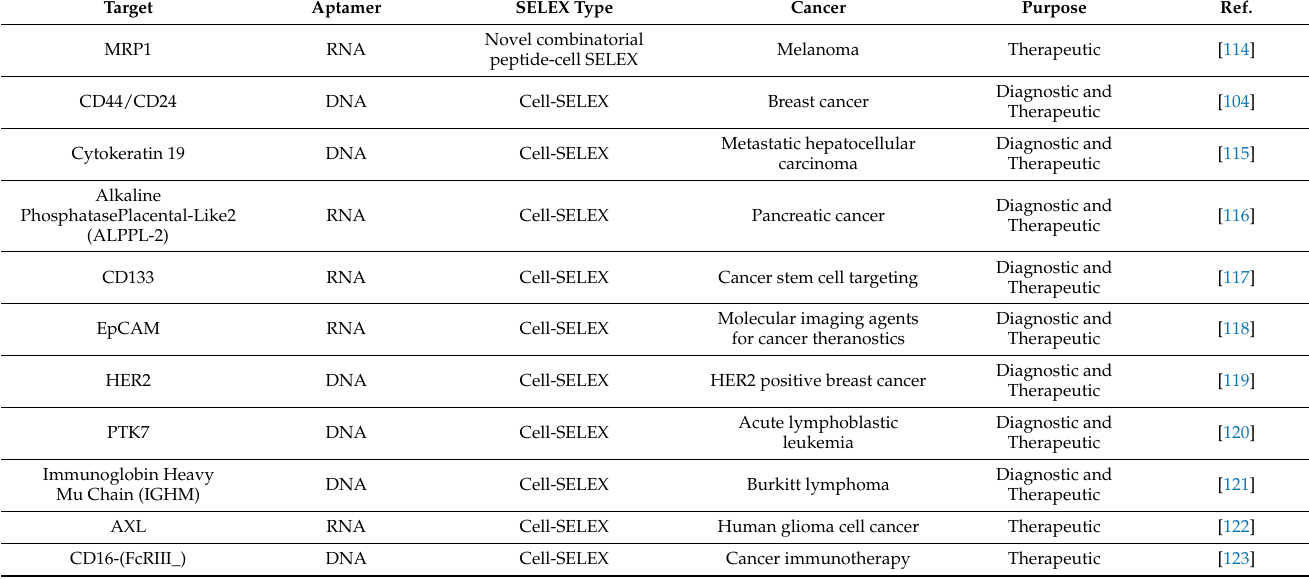
Table 2. Cell-SELEX-derived aptamers for cancer research.